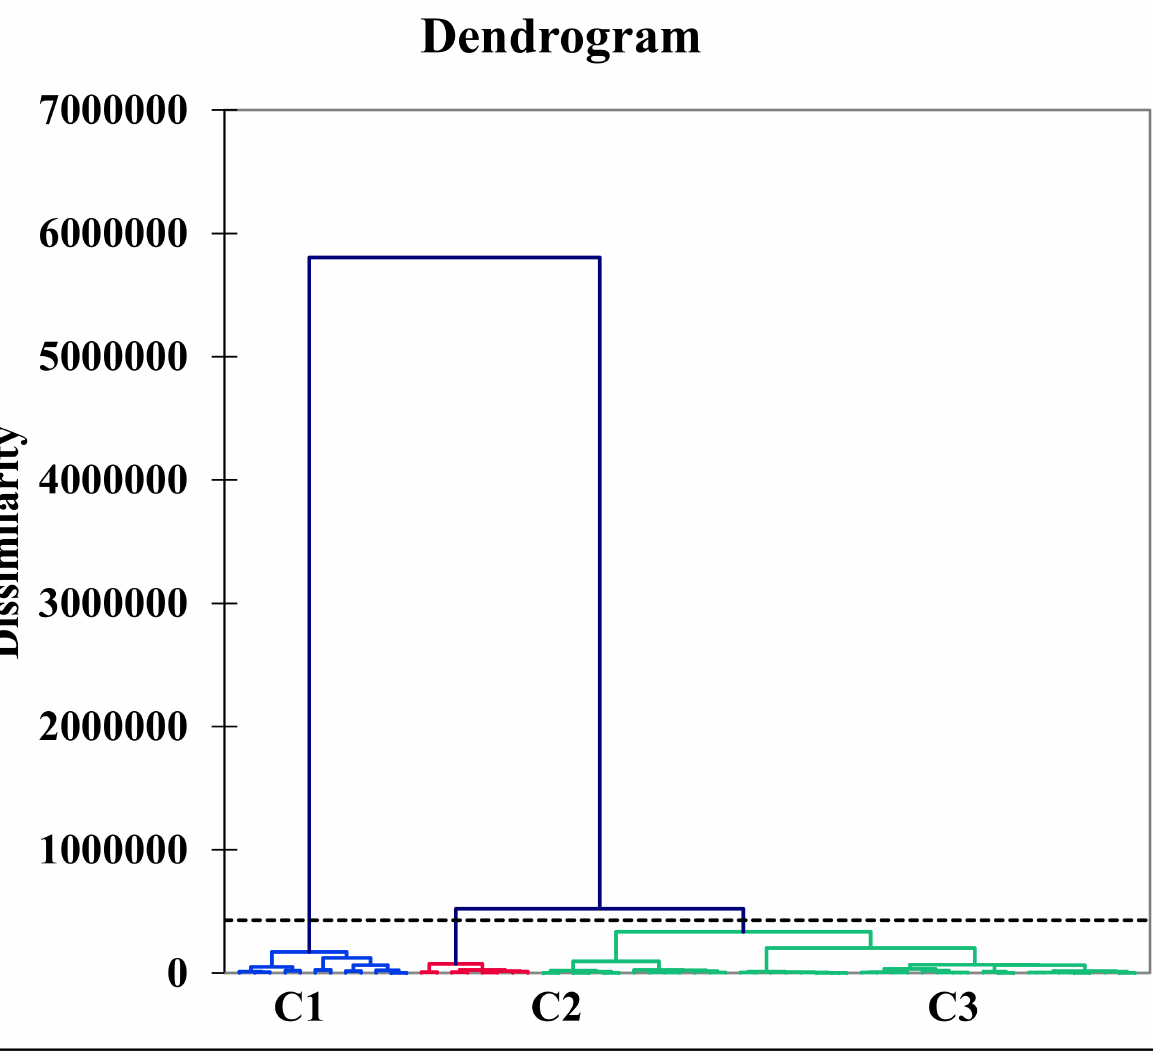
Figure 6. Clustering analysis showing the distribution of groundwater samples after Ward’s classification into three distinct clusters C1, C2, and C3, in the ultramafic terrain of Malakand, Northern